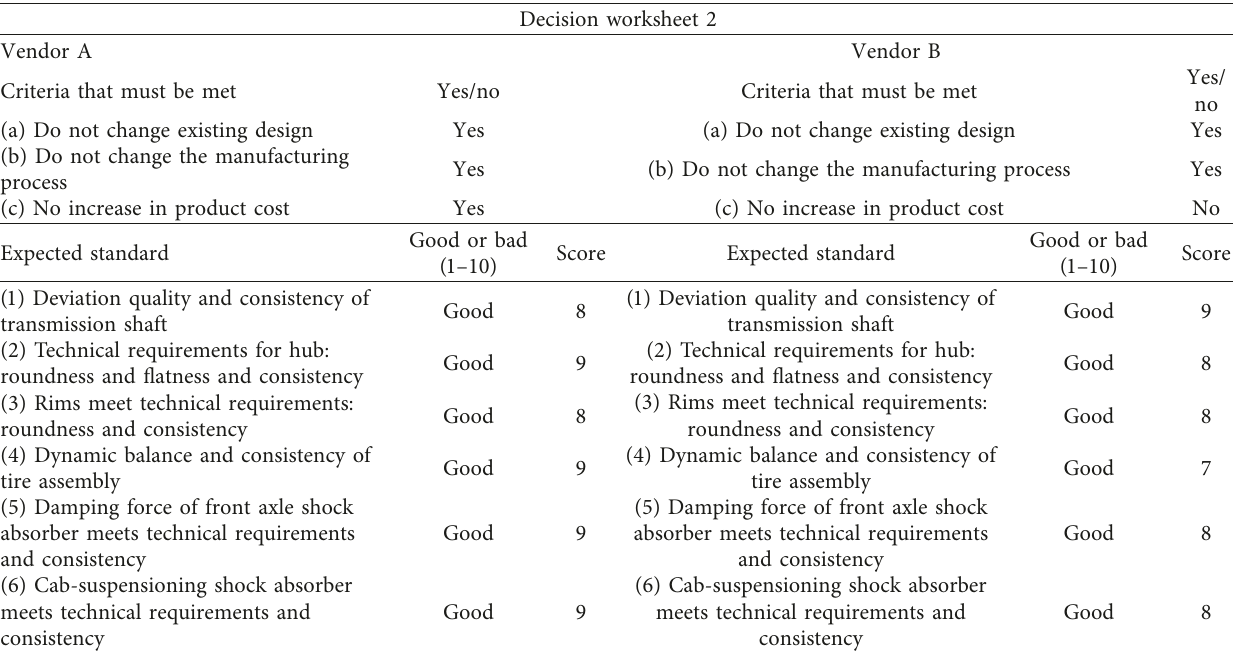
Table 8: Vendor decision